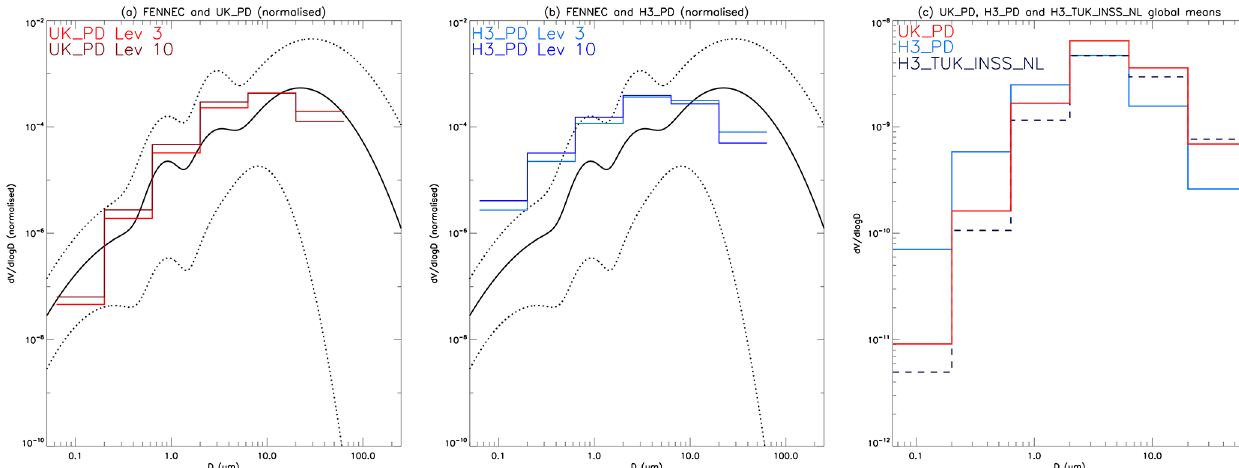
Figure 3. Dust volume size distributions, including the (a) normalised distribution from a fit to FENNEC mean, maximum and minimum data (Ryder et al., 2013) and from a multi-annual June mean of UK_PD data averaged over a rectangular area 13–4 ◦ W, 21 ◦ S–26 ◦ N, covering the FENNEC campaign region, for model levels 3 (approx. 96m) and 10 (approx. 770m), and corresponding to the height range of most of the FENNEC measurements. (b) Same as panel (a) but for H3_PD. (c) Global mean size distribution from UK_PD, H3_PD and